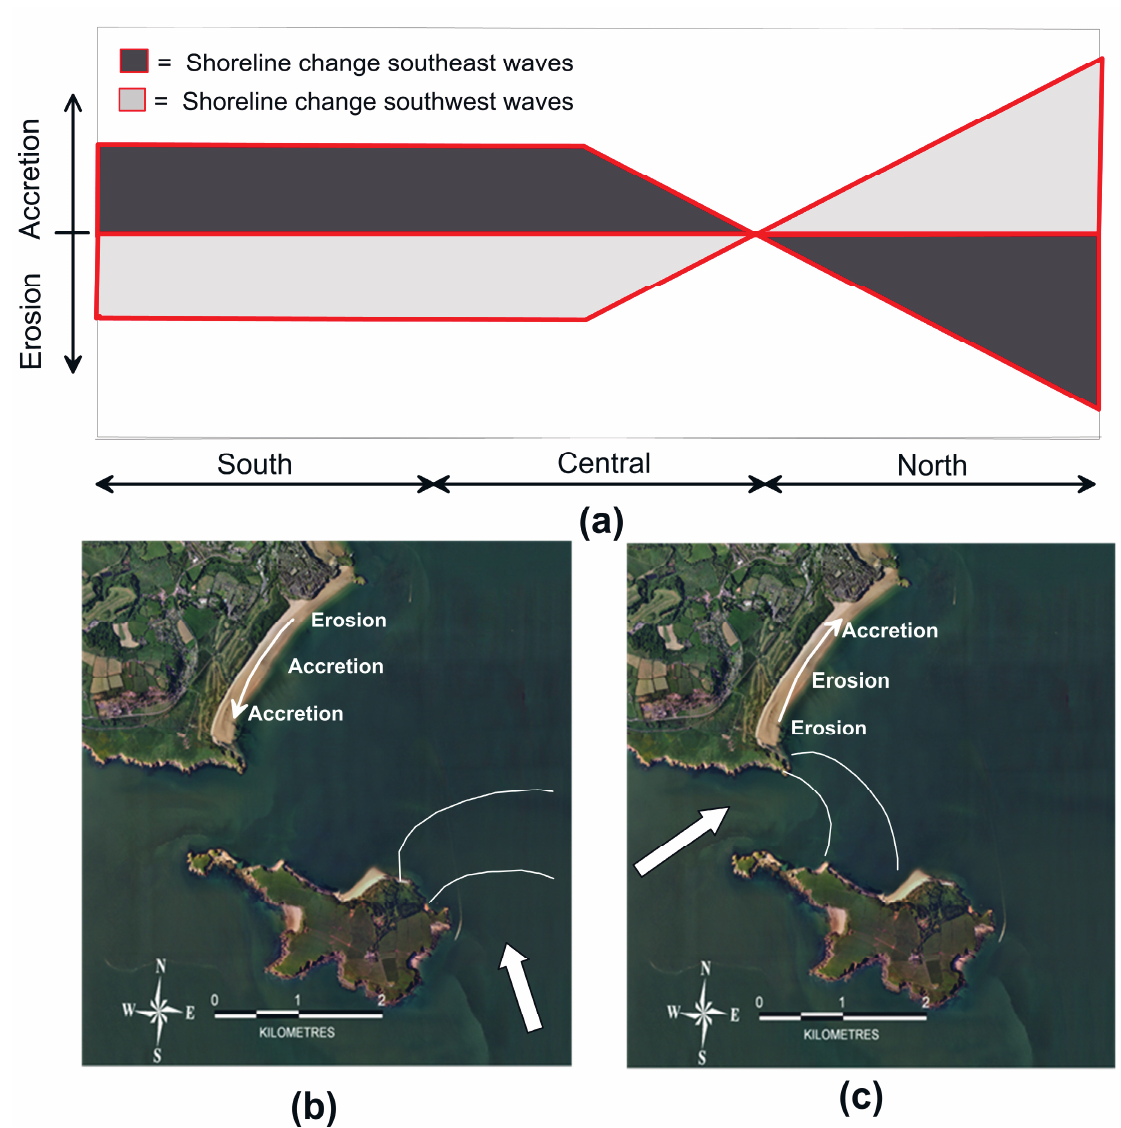
Figure 8. ( a ) A graphical illustration of the effects of southwesterly and southeasterly wave regimes have on Tenby South Sands; ( b ) a simplified conceptual model of wave propagation to nearshore based on waves from a south-westerly direction; and ( c ) a simplified conceptual model of wave propagation from a southeasterly